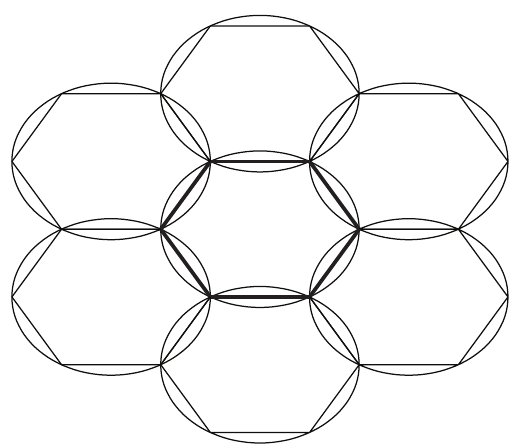
Figure 5: Proof of P B ( α > 3